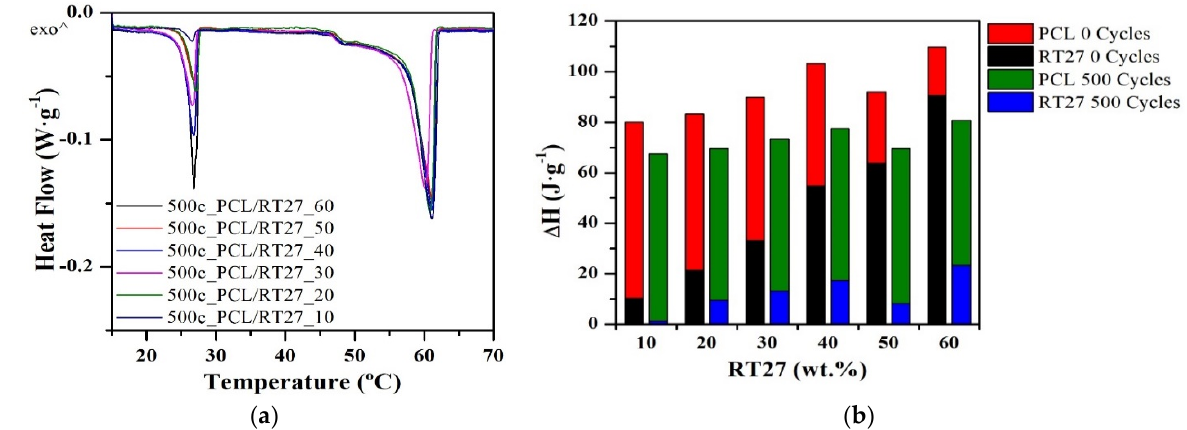
Figure 6. ( a ) Heat flow curves before the thermal cycling of RT27 CSS-PCM; ( b ) Enthalpy and melting temperature results before and after the thermal cycling of RT27 CSS-PCM.